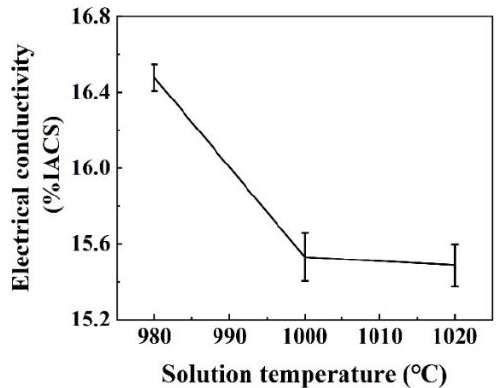
Figure 8. The variation of electrical conductivity with the increasing solution treatment temperature.